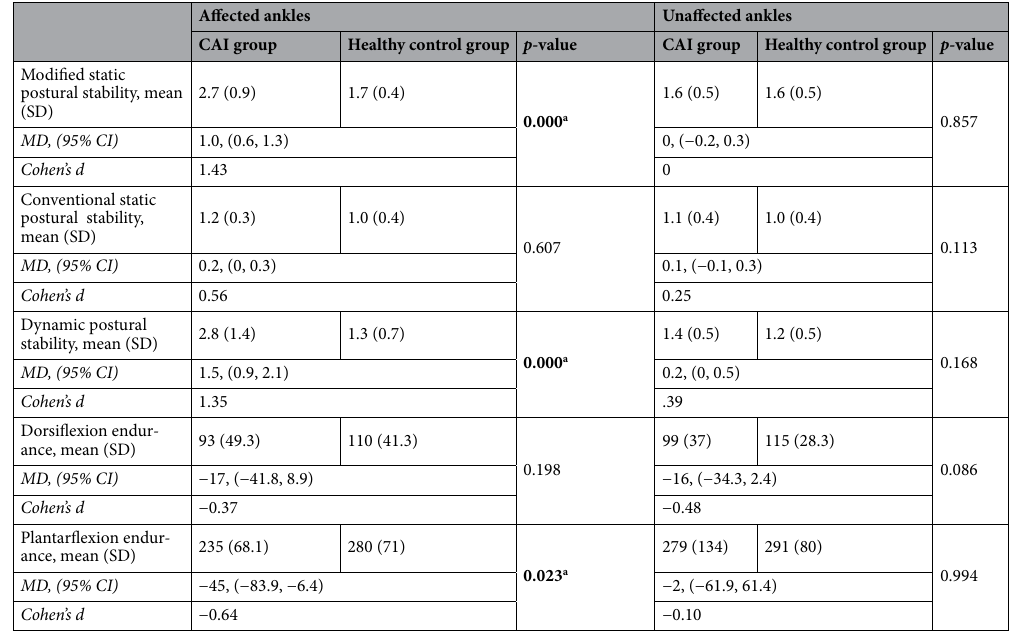
Table 2. Modified static postural stability, conventional static postural stability, dynamic postural stability, and muscle endurance in patients with CAI and healthy controls. Bold means statistically significant between groups. Postural stability (degree) and muscle endurance (J) are expressed as mean ± standard deviation at 120°/s. CAI chronic ankle instability,; MD mean difference,; CI confidence interval,; SD standard deviation. a Statistically